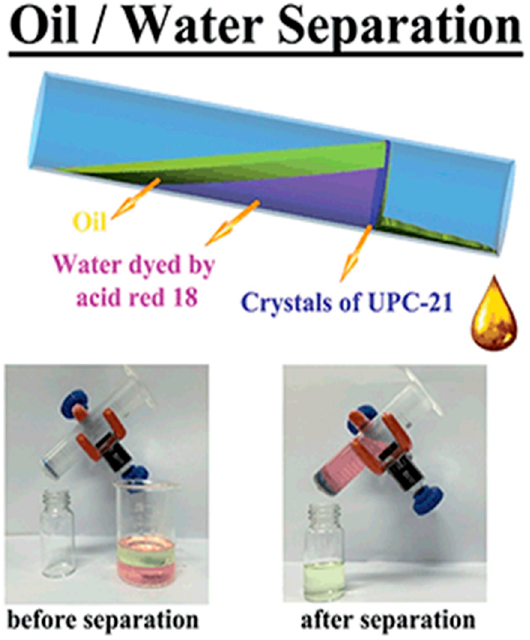
Figure 4. Photographs showing the status of separation experiments, oil/water separation efficiency. Water was colored with acid red 18 for observation. Reprinted with permission [65] Copyright 2016, Royal Society of Chemistry.